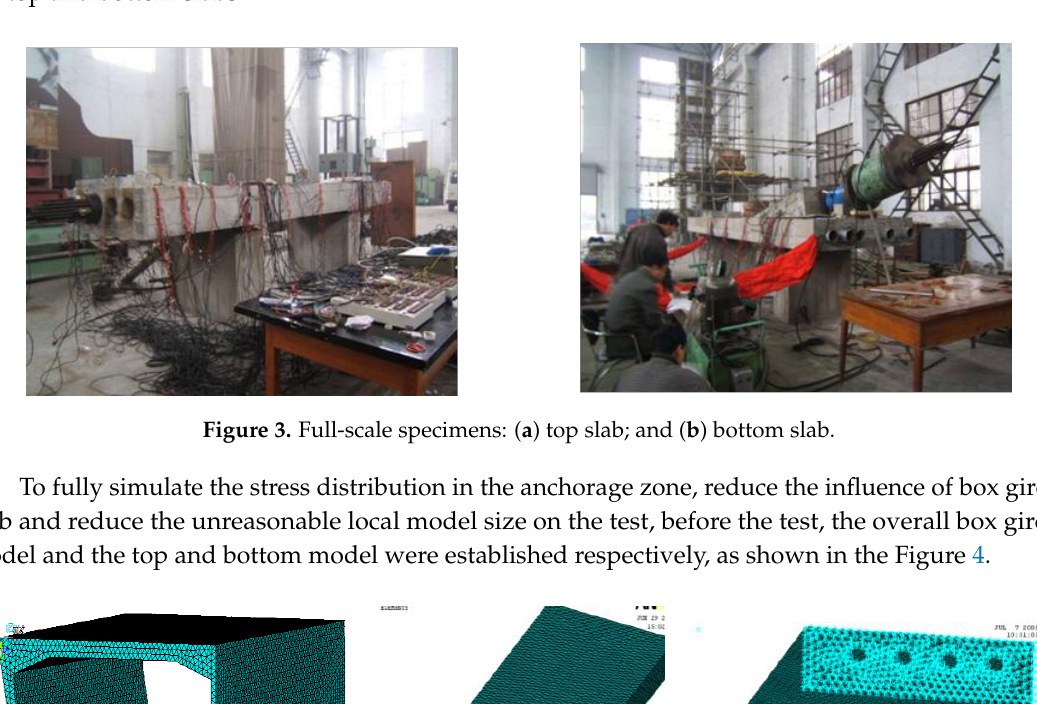
Figure 4. Global and local ANSYS models: ( a ) box girder; ( b ) top slab (1.4 m × 6 m ); and ( c ) bottom slab (1.6 m × 7 m ).